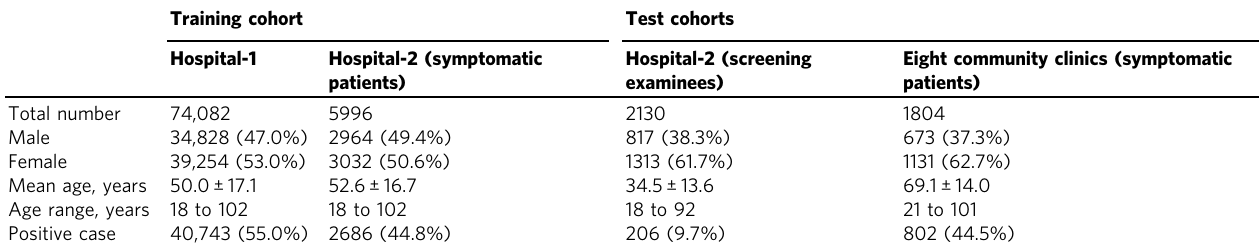
Table 1 Study population characteristics of the chest radiograph at diverse institutes (CRADI)